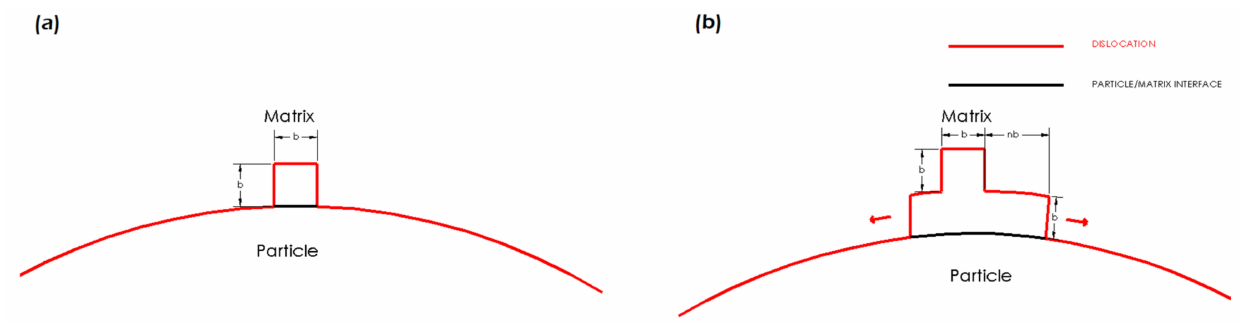
Figure 1. The initial detachment ( a ) leads to kink propagation ( b ) as part of the detachment process. The slip plane is the plane of the page, and the climb direction is perpendicular to the